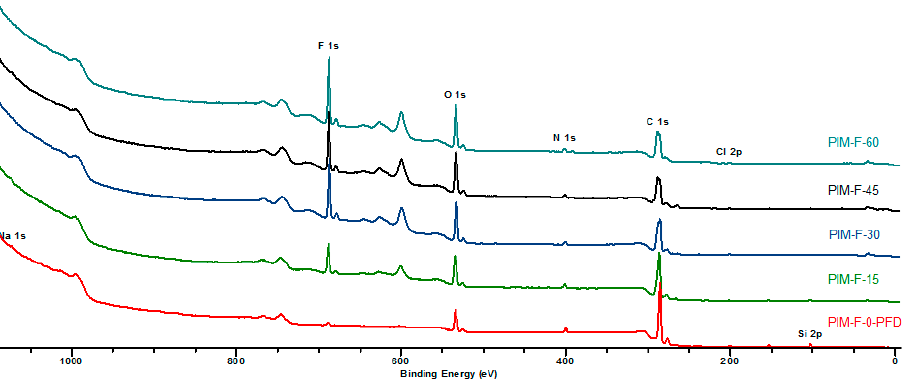
Figure 6. The overall XPS spectra of the surfaces of the control sample (PIM-F-0-PFD) and PIM-1 samples fluorinated for 15 (PIM-F-15), 30 (PIM-F-30), 45 (PIM-F-45) and 60 min (PIM-F-60).